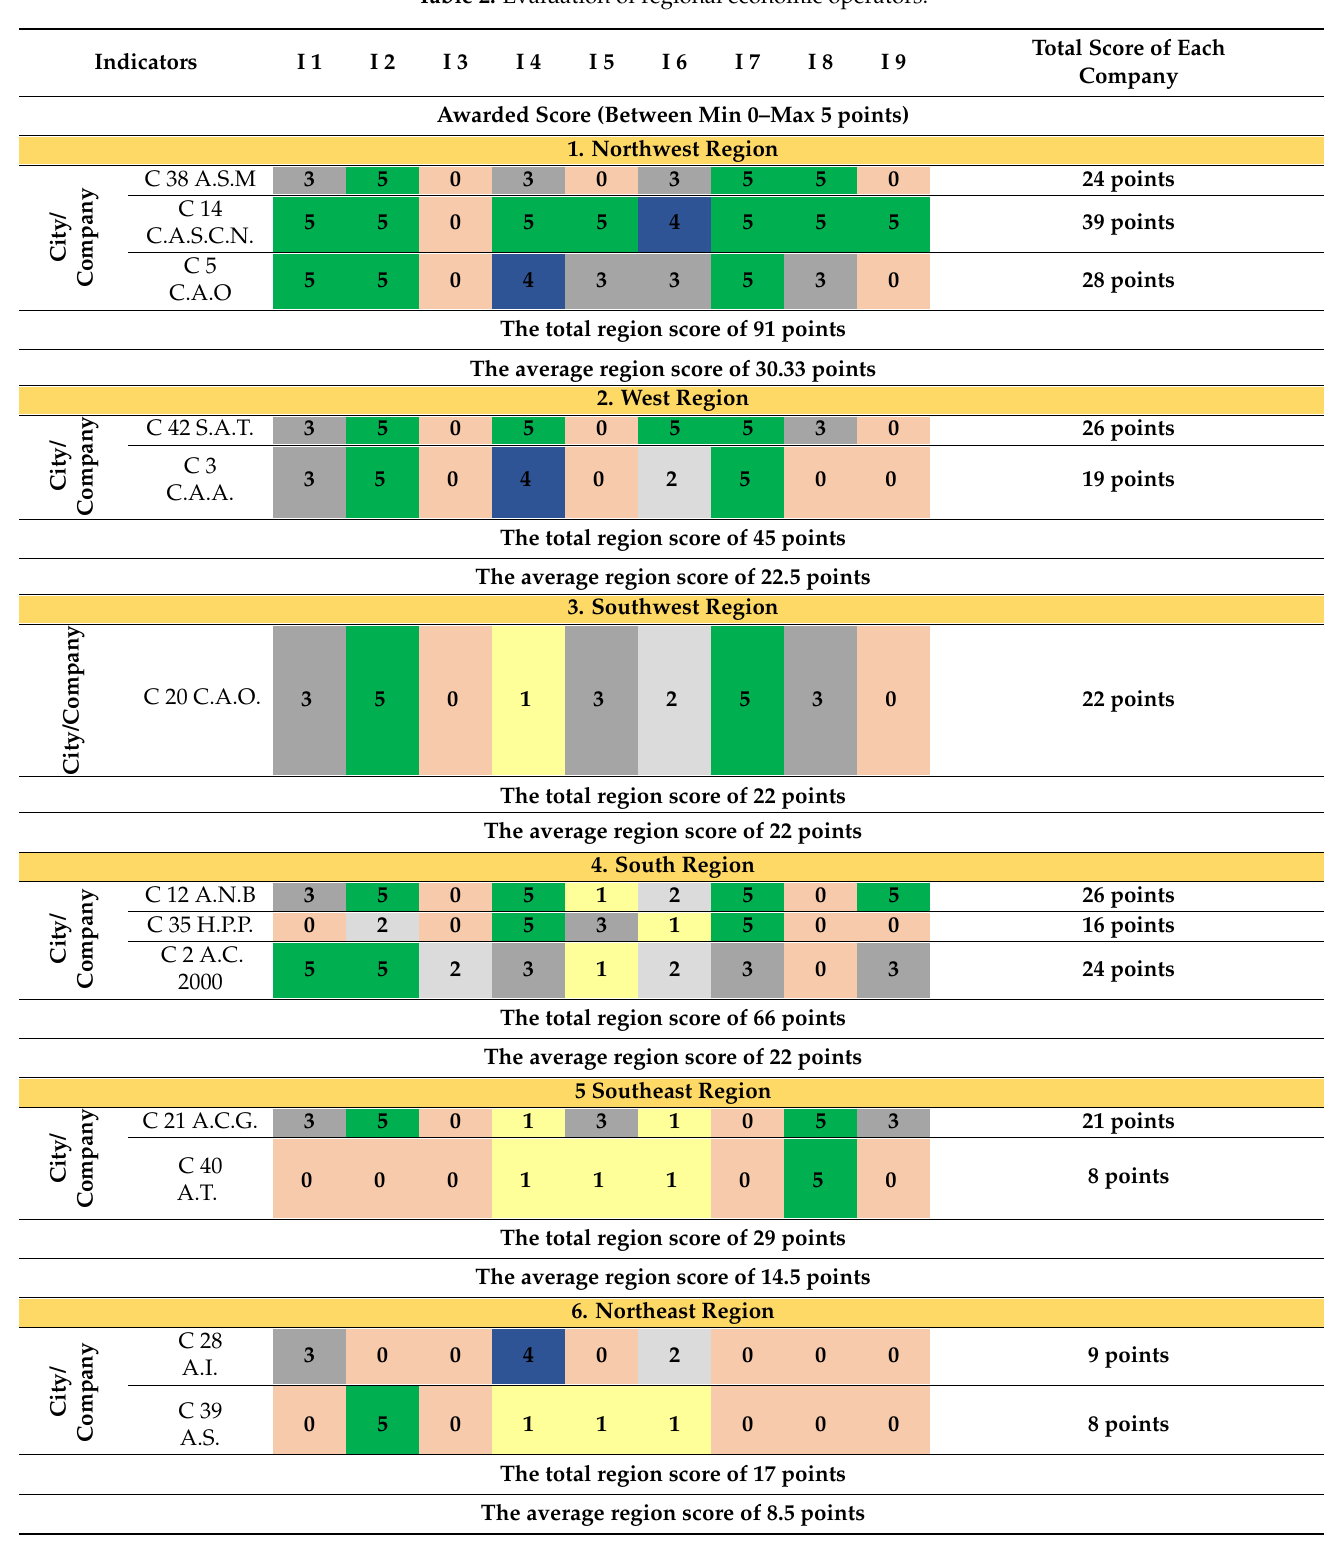
Table 2. Evaluation of regional economic operators.